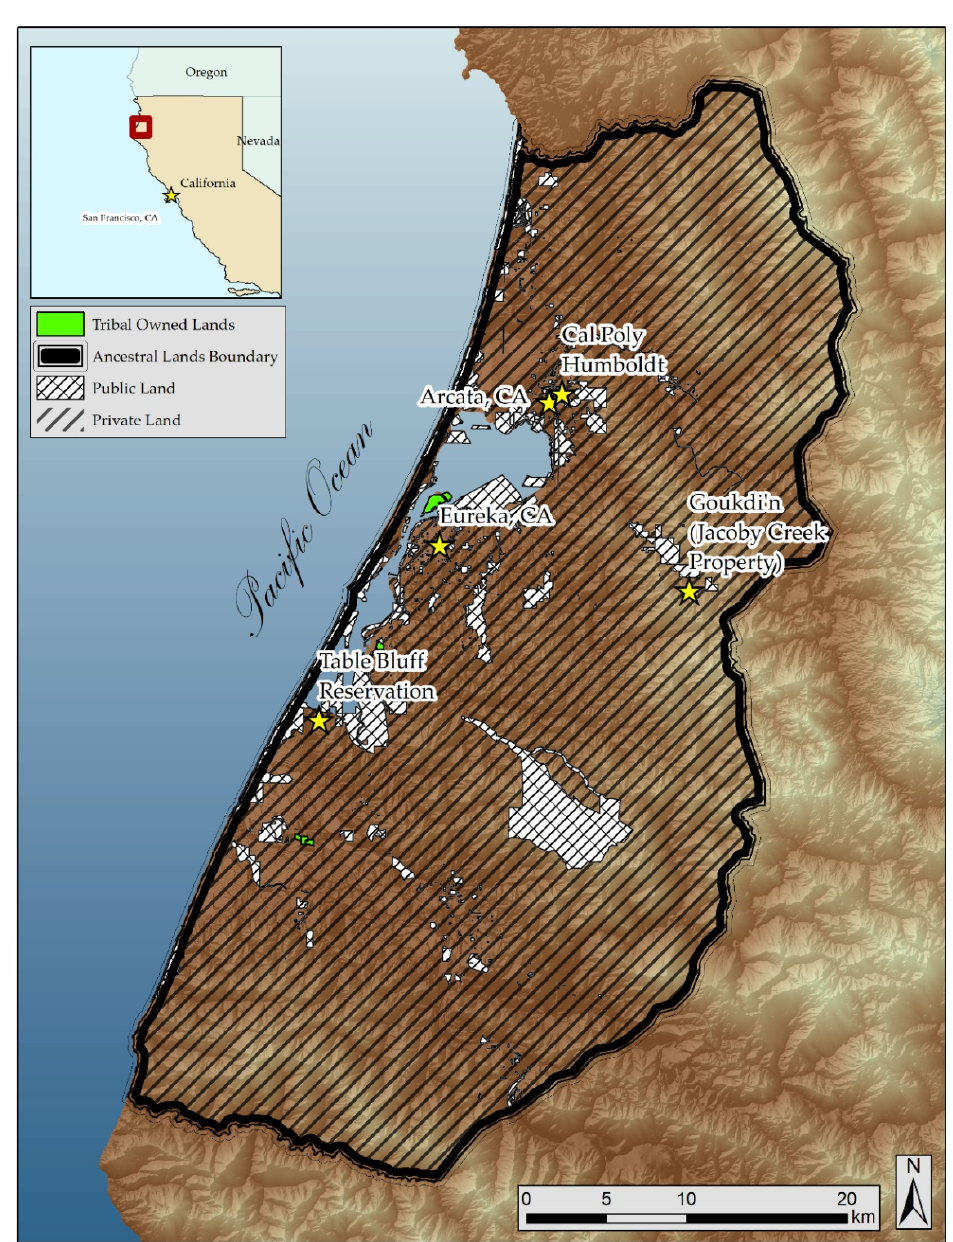
Figure 1. Wiyot Tribe ancestral lands in the northwest corner of California, USA (black border). Private lands (black stripes) within Wiyot Tribe’s ancestral lands encompassing the vast majority of the area. Stars indicate two cities, Arcata and Eureka, as well as the Cal Poly Humboldt campus, Goukdi’n, and the Table Bluff Reservation. Green polygons indicate land owned by the Wiyot Tribe. Grey polygons with crosshatching indicate public lands within the Wiyot Tribe ancestral lands boundary. The inset map locates the Wiyot Tribe ancestral lands (red box) in the northwest corner of California.